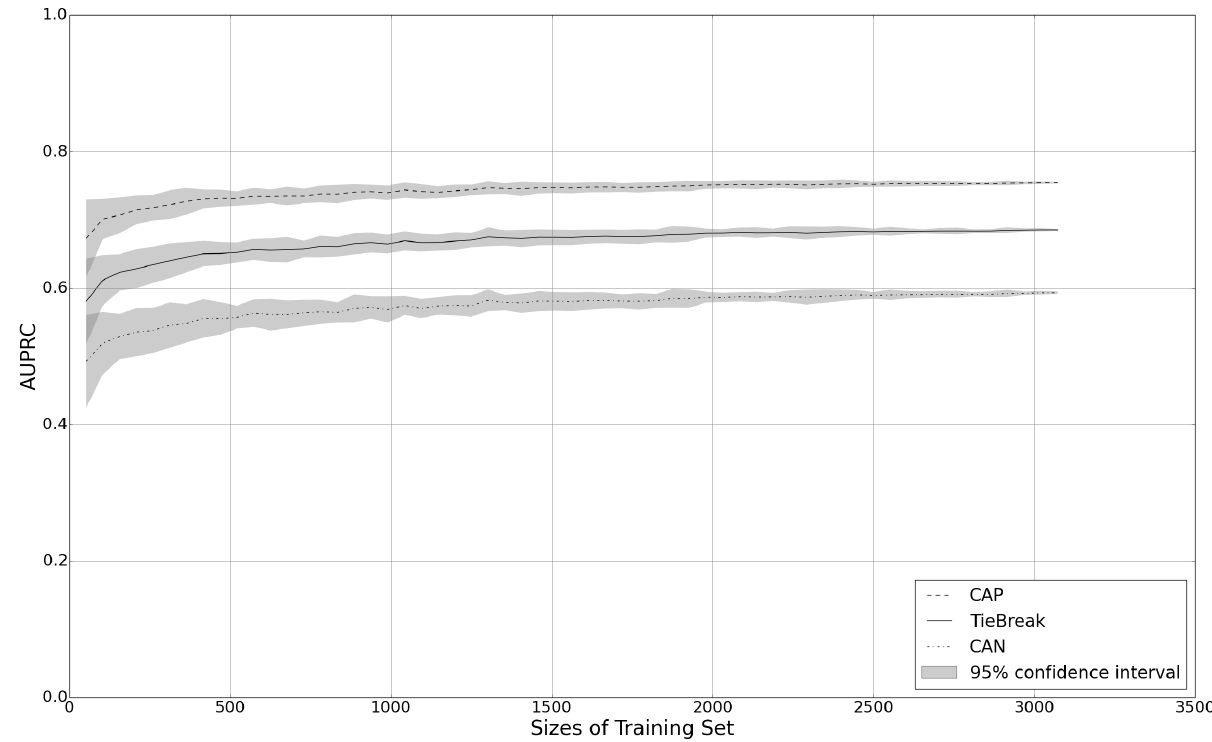
Figure 7. Performance of the SYND (synthetic health issue) classifier with a varying amount of training